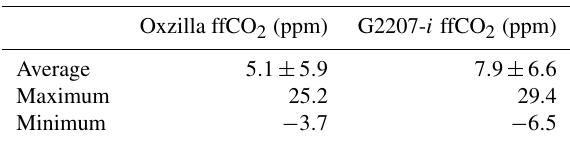
Table 4. Comparison of ffCO 2 values calculated from the Oxzilla and G2207- i O 2 measurements. Average values are given with ± 1 σ standard